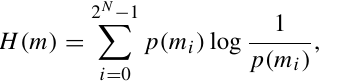
Table 5 Results of chi-square test of ciphertext images Image x